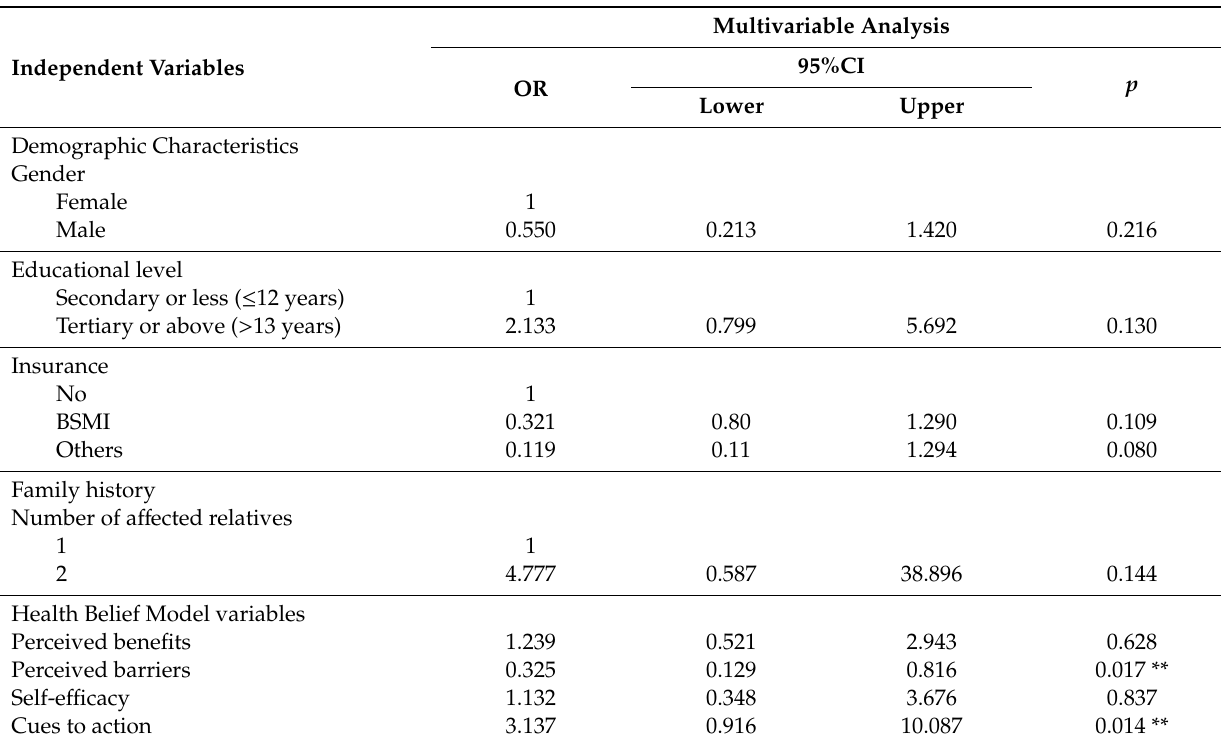
Table 2. Factors associated with the participation of colonoscopy screening (received colonoscopy or not received